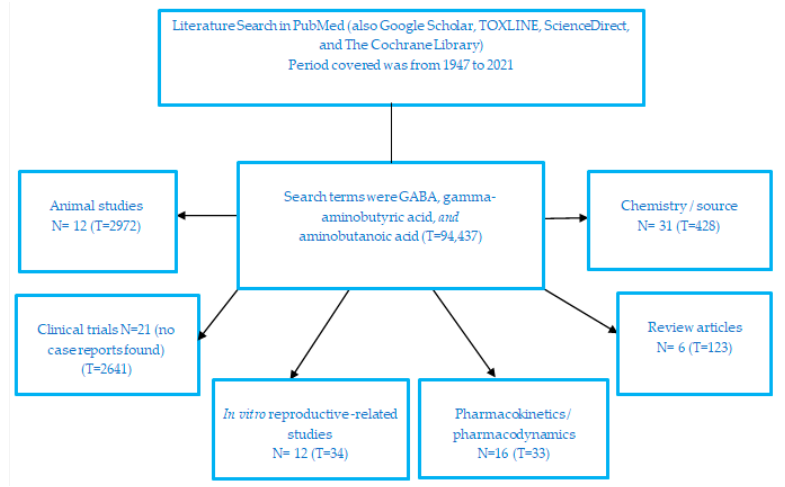
Figure 1. Literature search strategy showing the combination of search terms used and the number of articles included in the manuscript and the total number of articles retrieved by each search for each outcome. Most publications were concerning GABA as a neurotransmitter, its metabolism, and its derivatives and prodrugs such as pregabalin, gabapentin, and articles describing GABA function as an innate metabolite in the human body. T, total articles retrieved; N, articles included in the review.